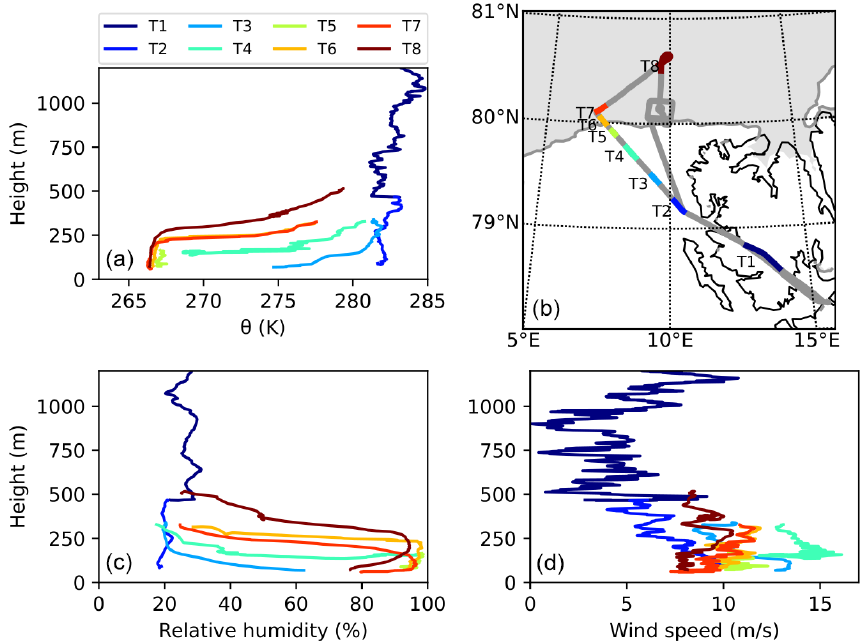
Figure 9. Vertical profiles of potential temperature (a) , relative humidity (c) and wind speed (d) as observed by the Polar 6 aircraft along its track line (b) . Gray shading in panel (b) corresponds to the AMSR2 sea ice concentration larger than 50% (https://seaice.uni-bremen.de/, last access: 25 January